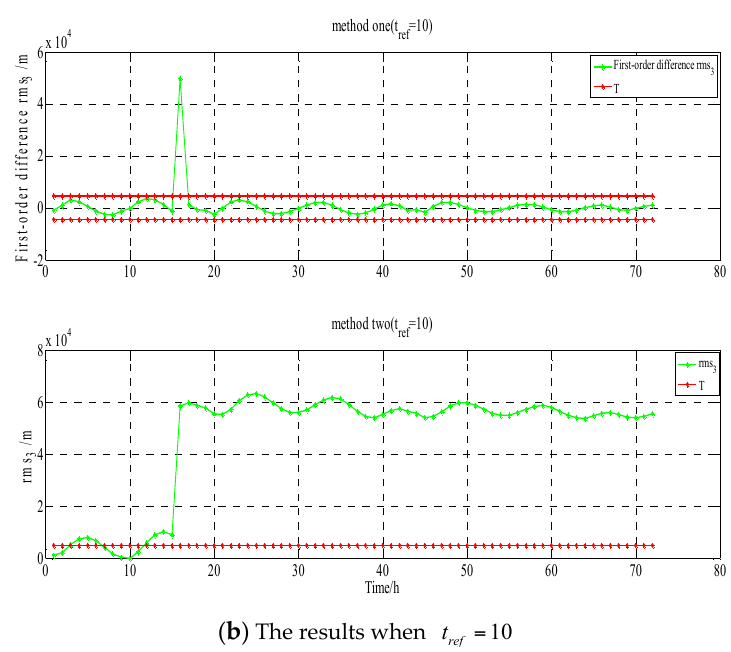
( b ) The results when  ( ) rms t  , Figure 8. The results for method one ( Figure 8. The results for method one ( ∇ rms 3 ( t ) /method two ( rms 3 ( t ) ) when t ref = 36 and t ref = 10, 3 respectively. respectively. Figure 8. The results for method one ( respectively.